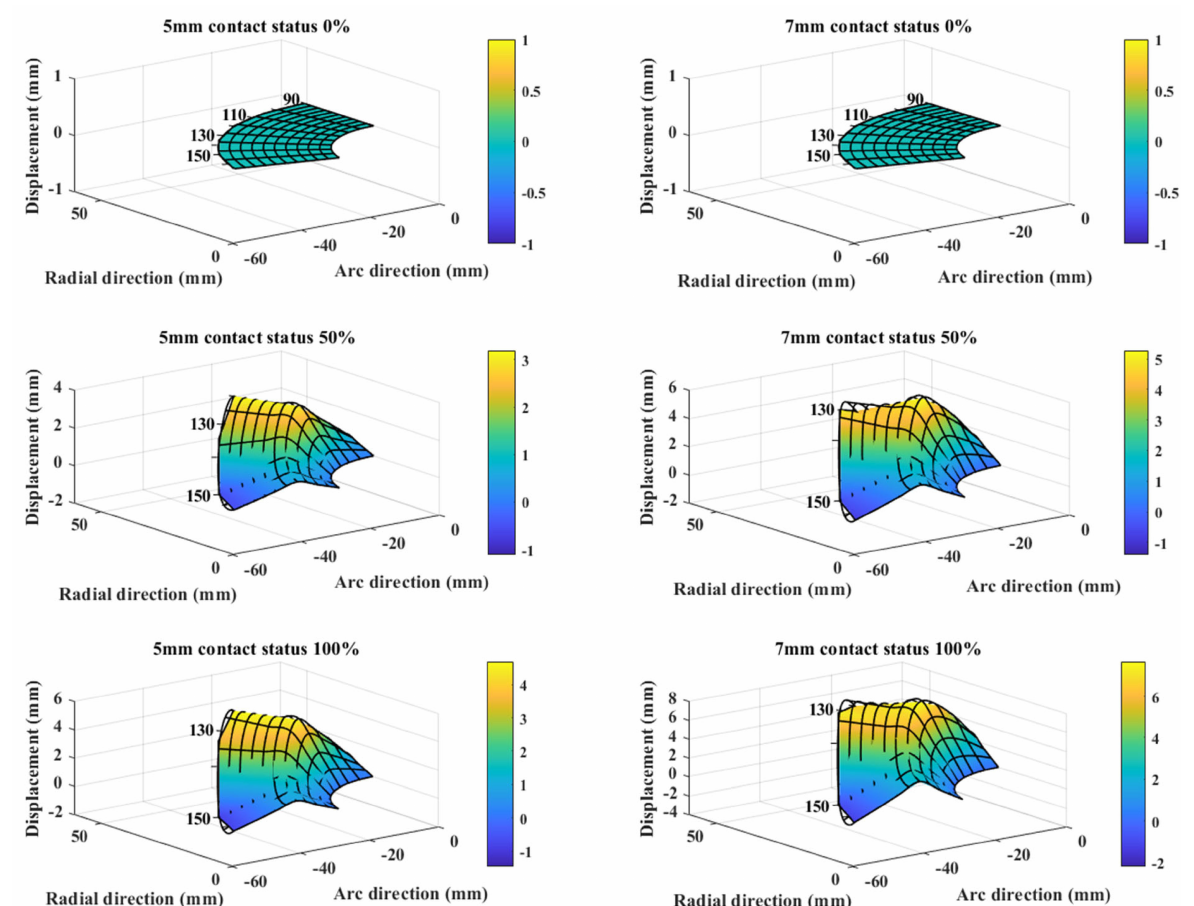
Figure 13. Displacement map of the smart cup at each sensing node during different stages of debris block